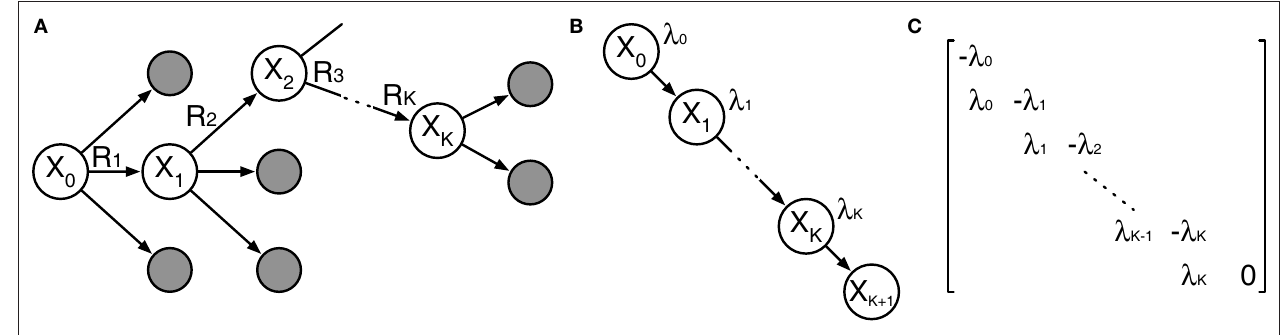
Figure 1 | Outline of proposed strategy for computing the probability that a reaction sequence completes in a given amount of time. (A) The reaction sequence picks out a sequence of states starting from X . (B) A continuous-time Markov chain describing the timing of transitions along that sequence of states. The 0 waiting time in state X is exponentially distributed with parameter λ = λ ( X ). (C) The rate matrix for the chain shown in (B) i i i